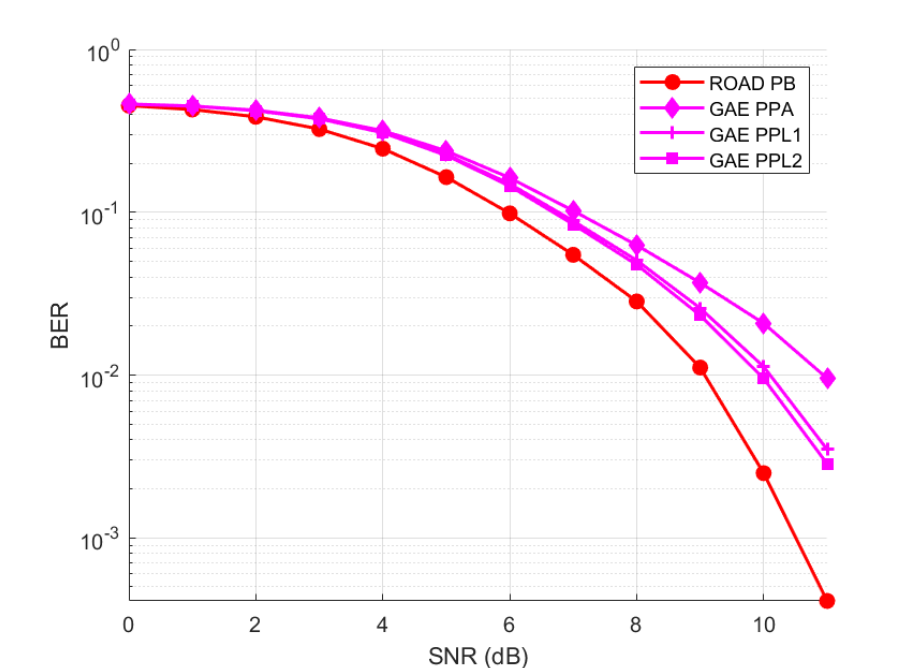
Figure 25. Performance of ROADPB vs. GAE enhanced pulse peak processors.